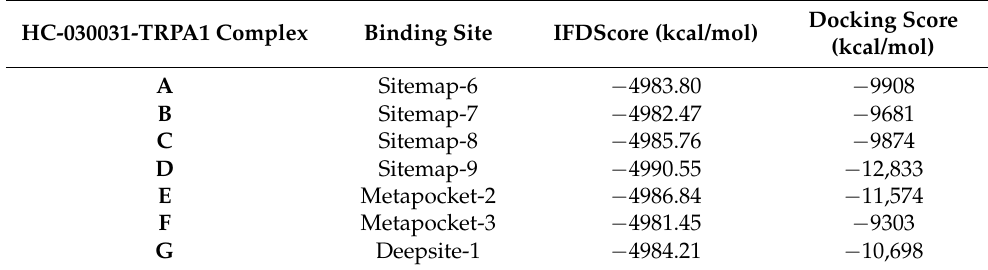
Table 5. Summary of all predicted binding sites for models based on 3J9P and 6PQQ. Sites excluded from further investigation are marked in red. The most prevalent binding site, consistent with ex- perimental reports, is marked in green.